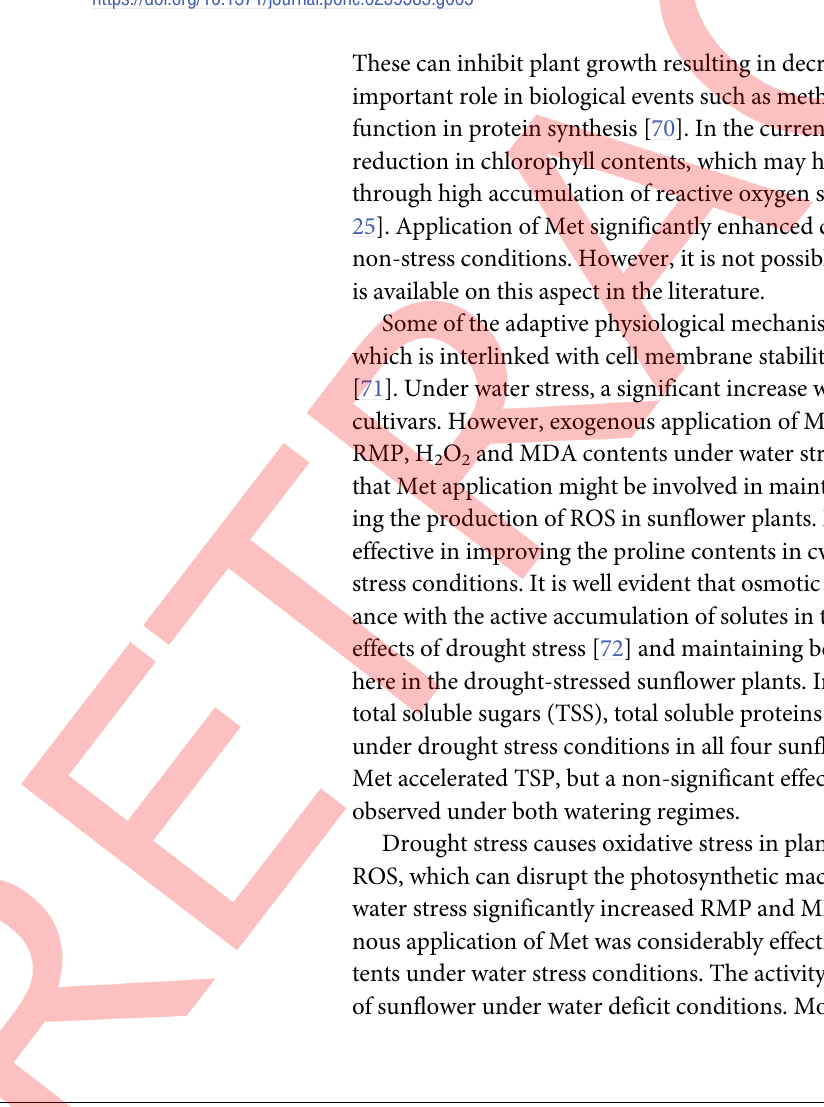
Fig 5. External supplementation of L-methionine regulates (A) ascorbic acid and (B) total phenolics in sunflower ( Helianthus annuus L.) plants grown under water deficit condition (Mean ± S.E.).